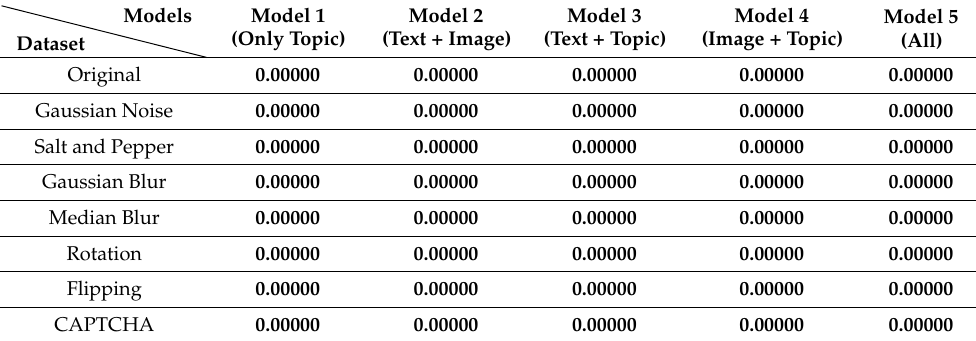
Table 16. p -values of the chi-square test with Baseline 1 for the Dredze dataset.